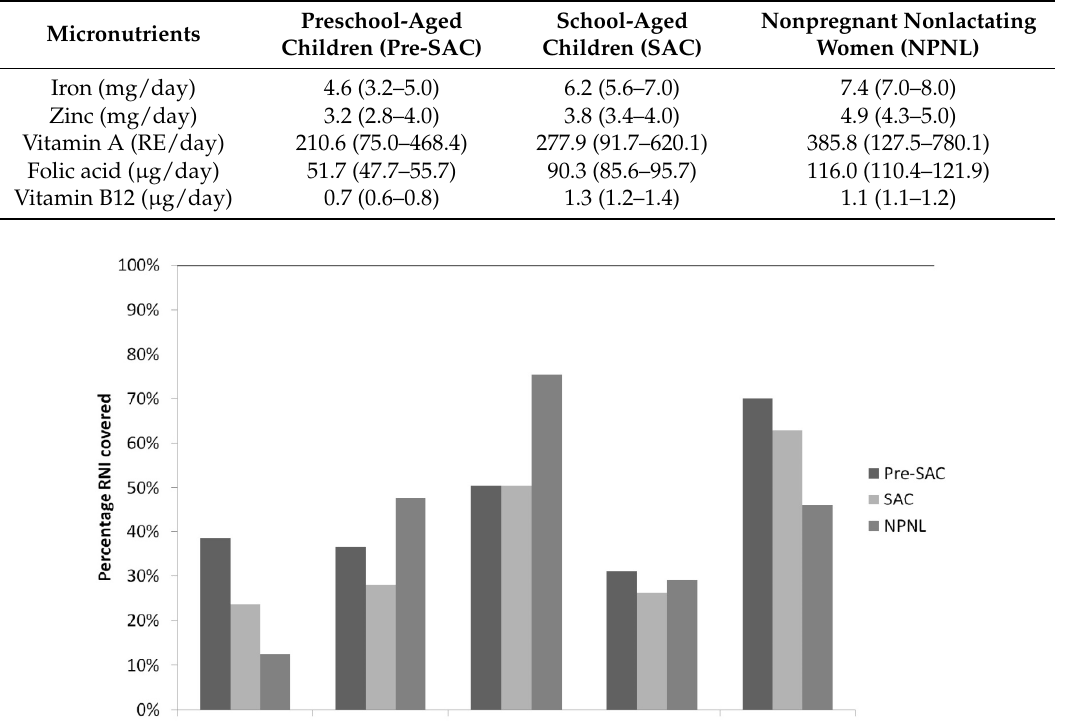
Figure 1. Percentage of iron, zinc, vitamin A, folate, and vitamin B12 recommended nutrient intake (RNI) covered by the diet per population group.